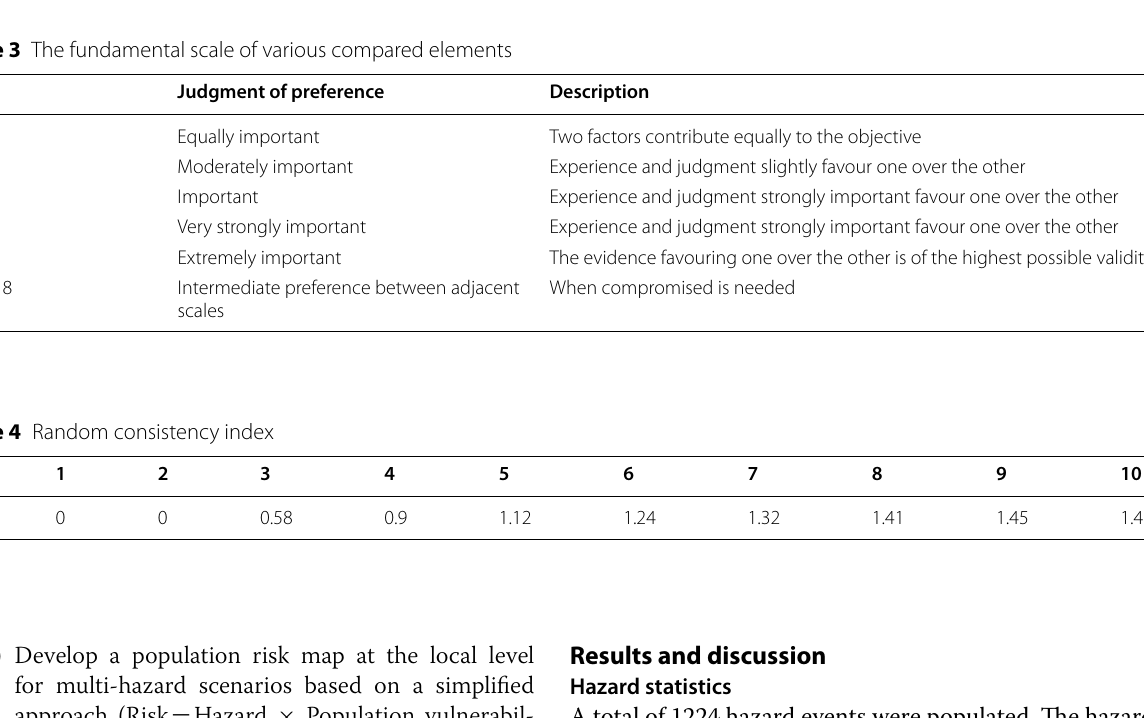
Hazard Population vulnerabil- = ×